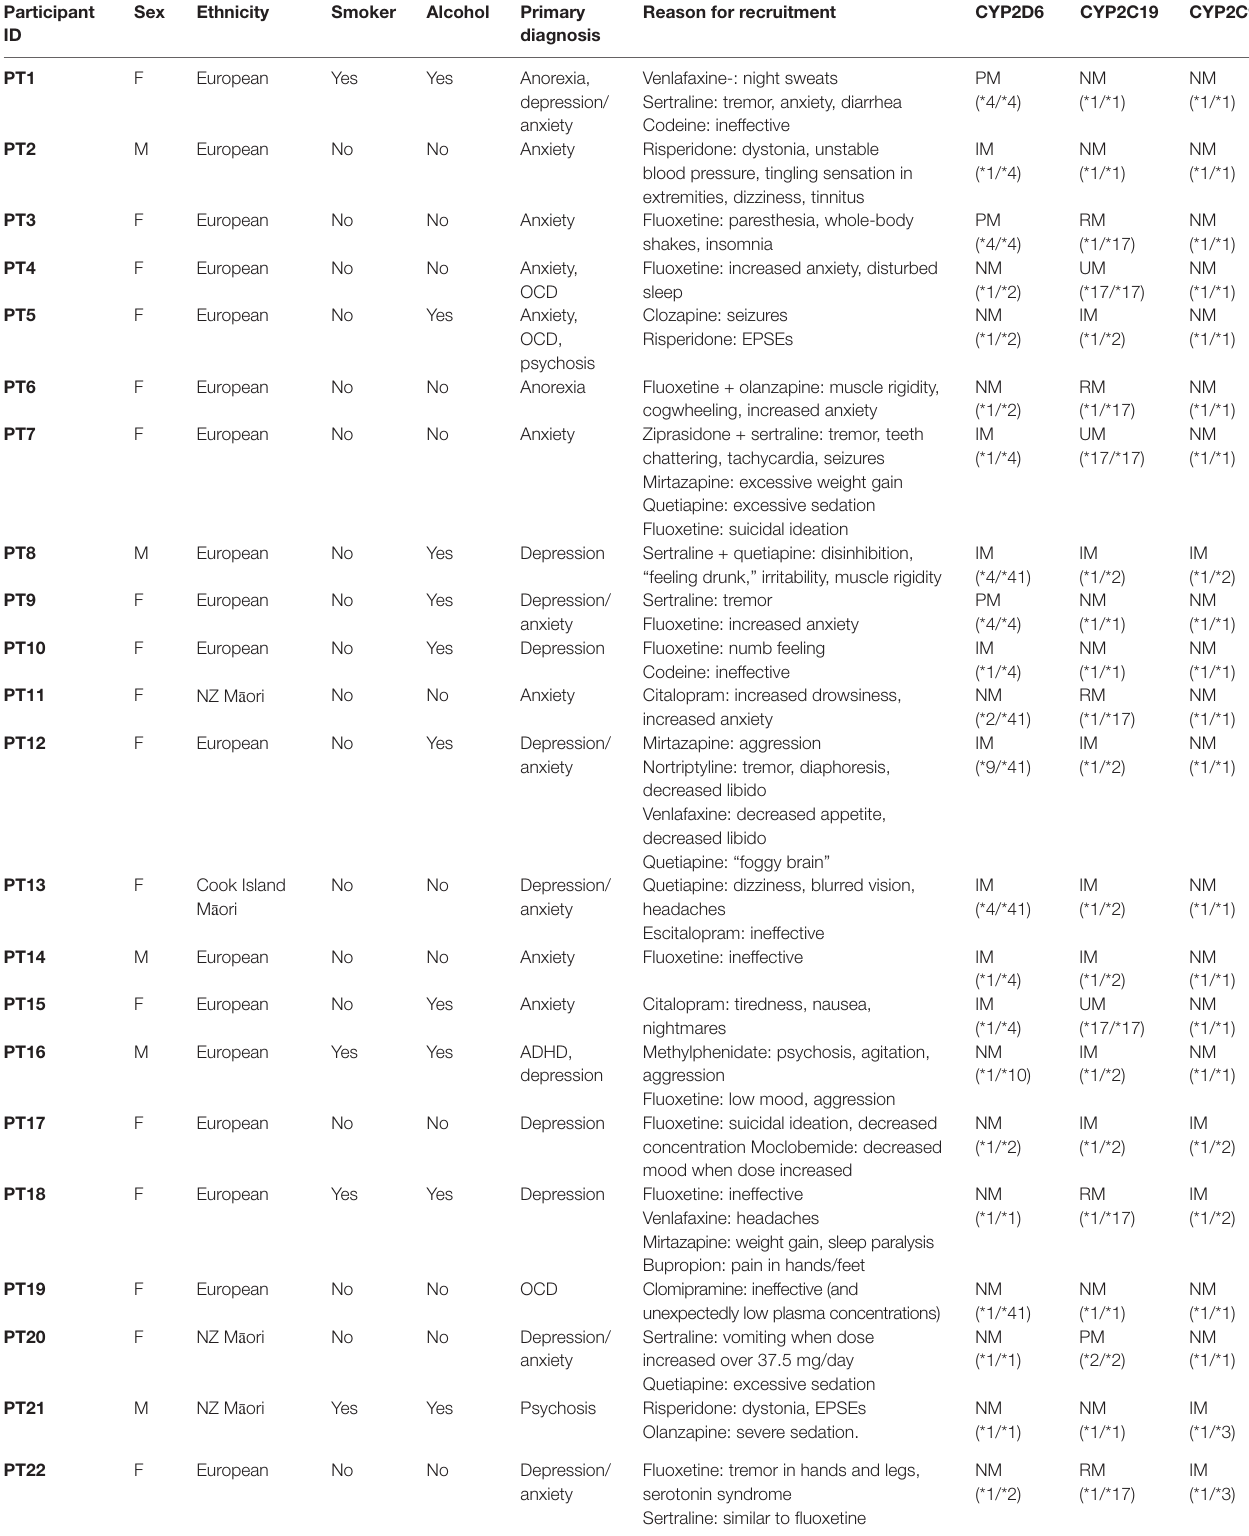
TABLE 1 | Participant demographics, genotype, and predicted